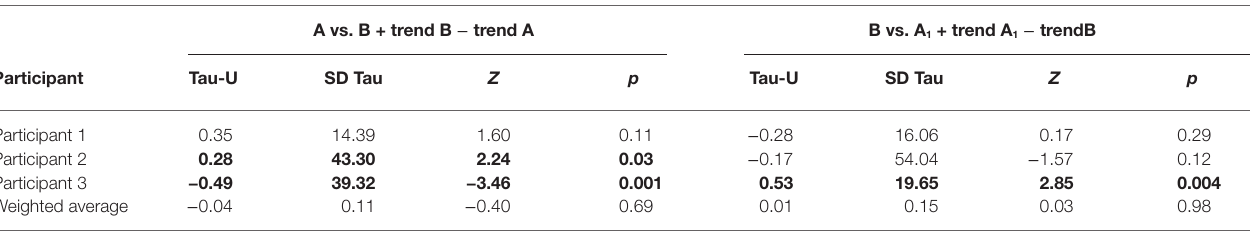
TABLE 4 | Tau-U calculations across phases for each participant.